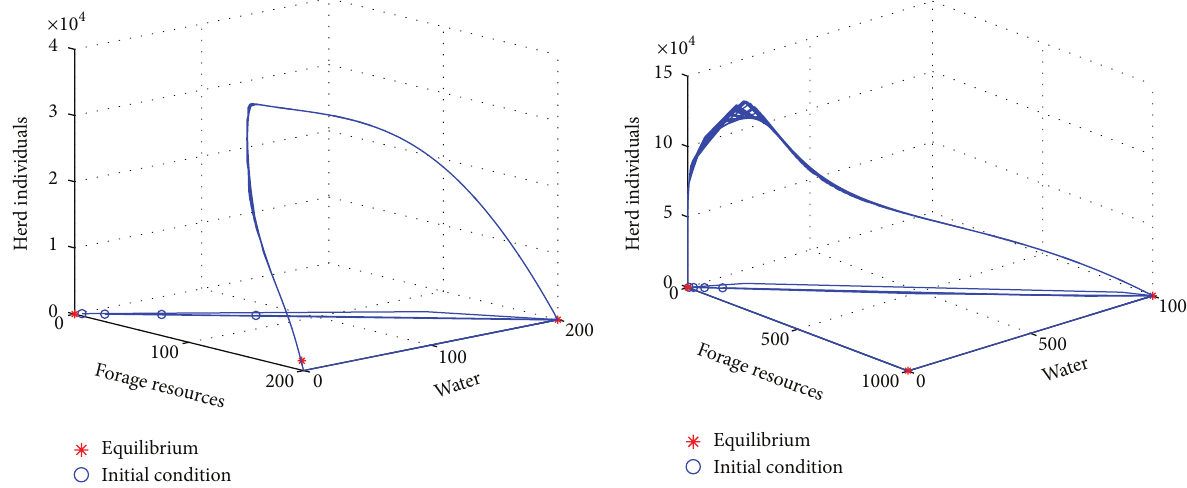
Figure 10: Phase portrait of System (2) showing the coexistence of 𝐸 10 , 𝐸 11 , 𝐸 12 . Equilibria 𝐸 11 and 𝐸 12 correspond to the removal of the pastoralists with their herd and persistence of forage or water resources. We can observe here the local asymptotic stability of 𝐸 11 = (𝐾 1 ,0,0) , = (0, 𝐾 ,0) , and 𝐸 = (0,0, 0) when 𝑟 = 400 kgDM/ha and 𝑝 = 3000 mm. The rest of parameters are in Tables 1 and 2. 𝐸 12 2 10 1